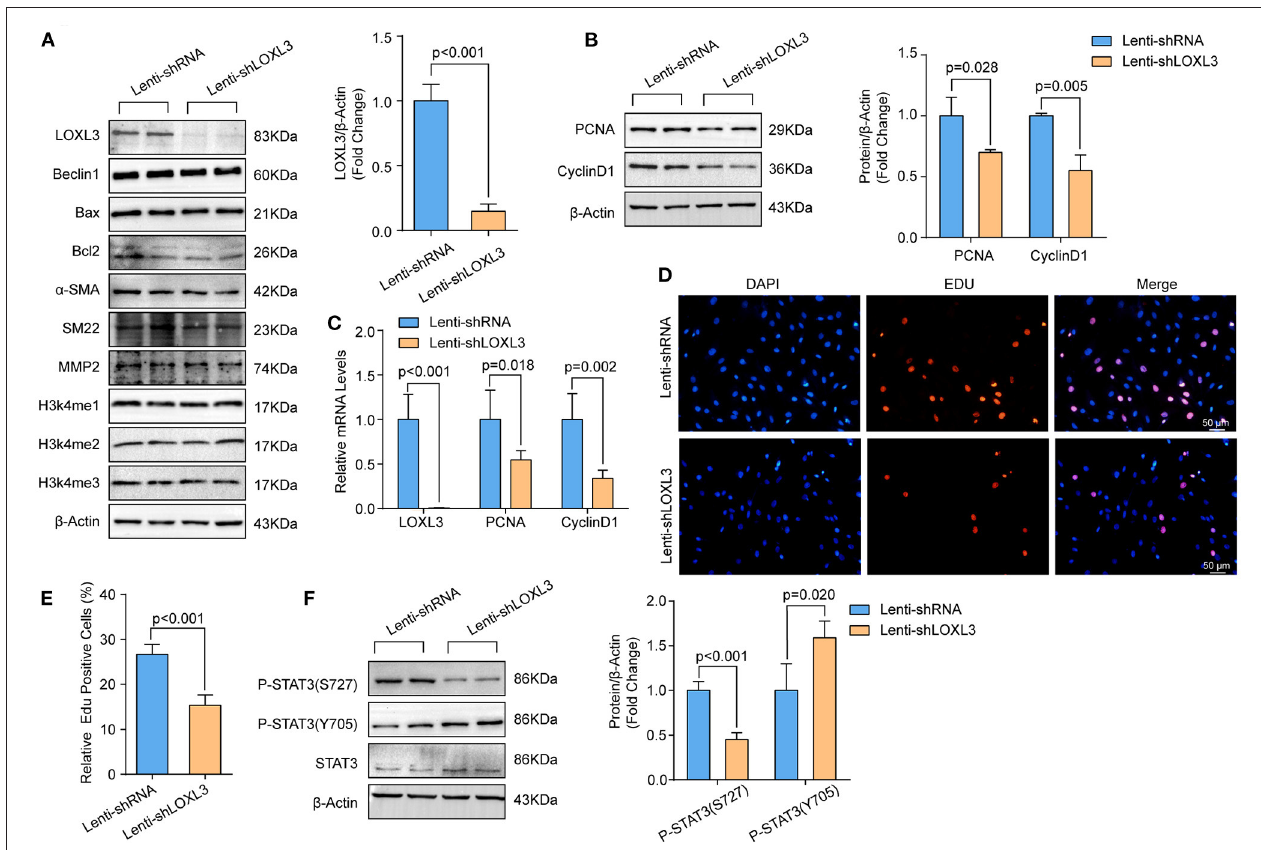
FIGURE 4 | LOXL3 knockdown suppressed the proliferation of primary cultured HASMCs. (A) The protein levels of LOXL3, Beclin 1, Bax, Bcl2, α -SMA, SM22, MMP2, H3K4me2, and H3K4me3 in HASMCs infected with lenti-shRNA or lenti-shLOXL3 ( n = 4). (B) The protein levels of the proliferation markers cyclin D1 and PCNA in HASMCs infected with lenti-shRNA or lenti-shLOXL3 ( n = 4). (C) The mRNA levels of LOXL3, cyclin D1, and PCNA in the indicated HASMCs were evaluated by RT-PCR ( n = 5). (D,E) The EdU assay was performed in HASMCs infected with lenti-shRNA or lenti-shLOXL3 (D) , and EdU-positive cells were quantified (E) ( n = 4). (F) Levels of STAT3 phosphorylated at serine 727 and tyrosine 705 in HASMCs infected with lenti-shRNA or lenti-shLOXL3 ( n = 4). β -Actin served as the loading